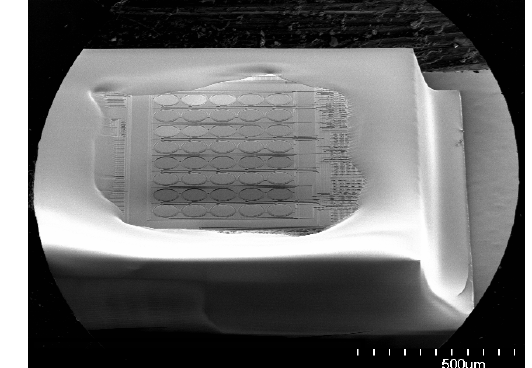
Figure 14. SEM image of a defect-free passivation.